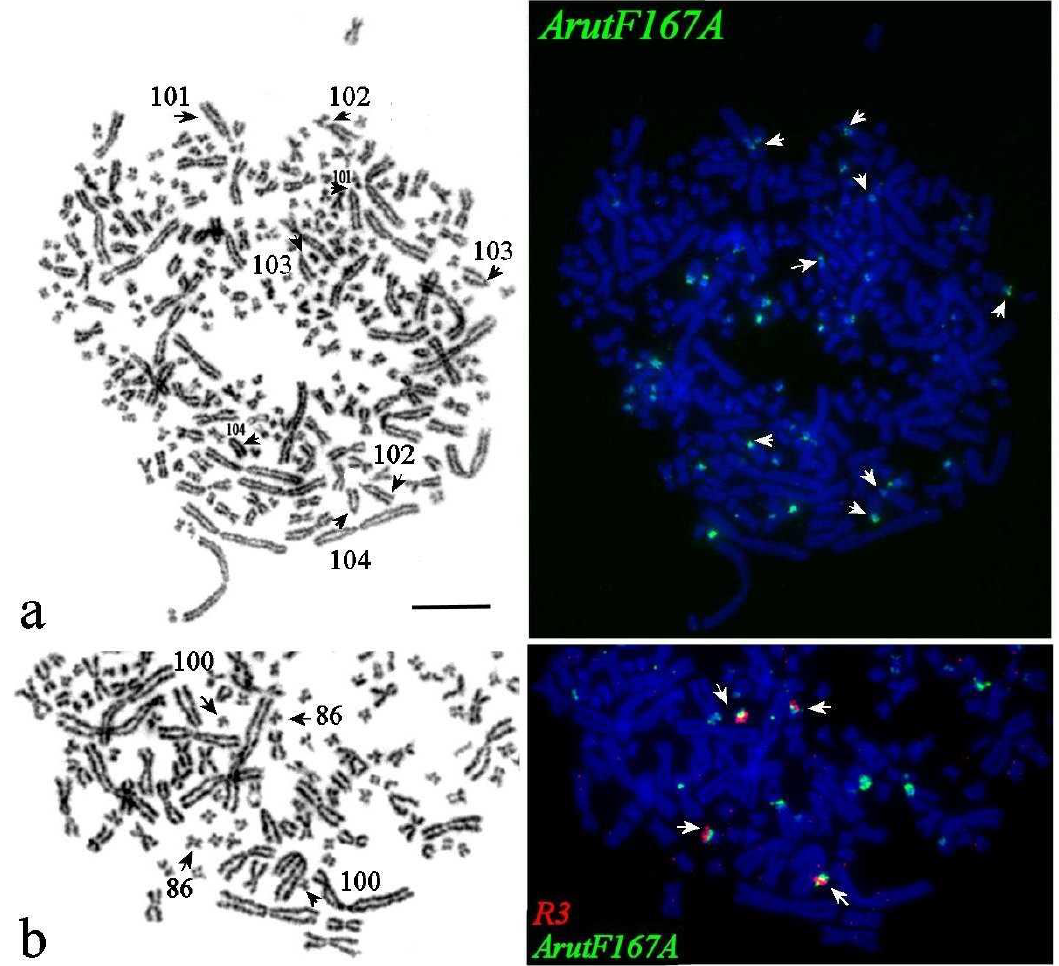
Figure 5. FISH of repetitive DNA probes on metaphase plates of the Siberian sturgeon ( a , b ). ( a ) ArutF167A on GTG-banded metaphase plate ( left ), arrows mark big acrocentric chromosomes with signals and arrowheads strong signals on ABAE 104. ( b ) satellite ArutF167A (green) and painting probe ARUT 57 (R3, red) on the part of GTG-banded metaphase plate ( below ). Arrows mark ABAE chromosomes 86 and 100. The scale bar is 10 µm.